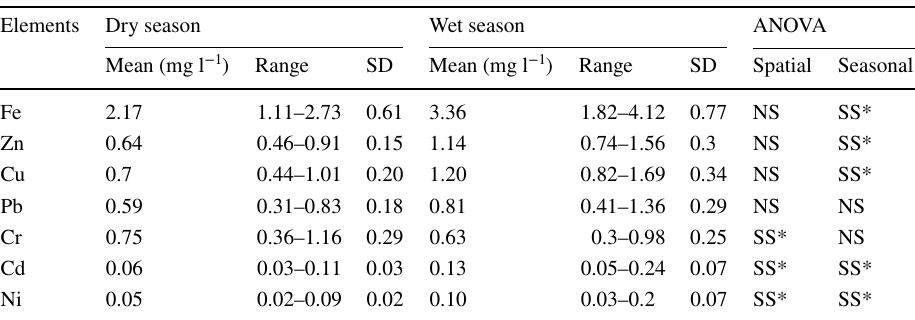
Table 8 ANOVA relation of heavy metals at different sampling location and different season